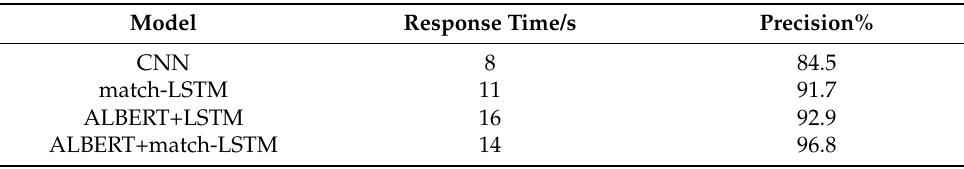
Table 9. Response time and precision of four network